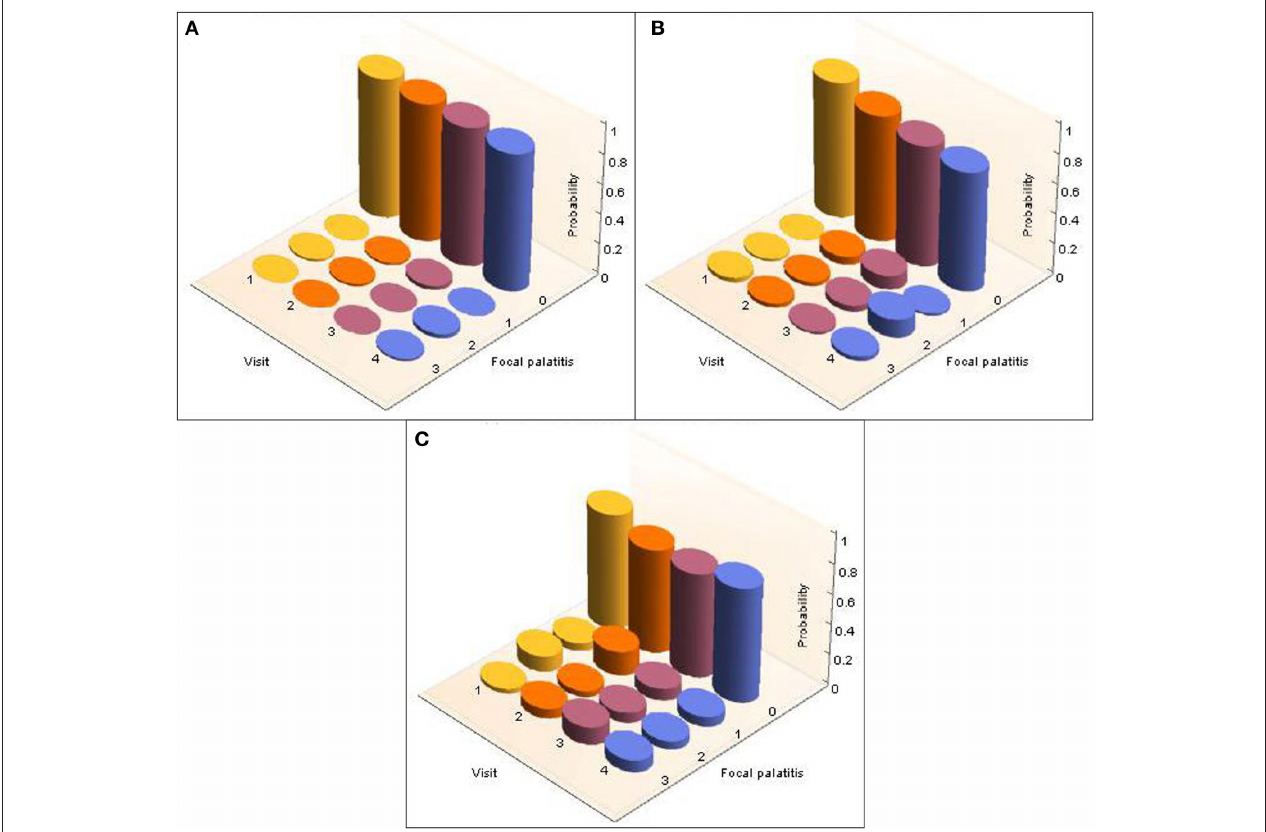
FIGURE 4 | 3-D column charts depicting the development of FP in terms of occurrence and severity in cheetahs from the Ann van Dyk Cheetah Centre (DW), seen on four different yet consecutive visits. The figures show the probabilities for FP in each of the palatal depressions that can potentially have FP. Note that dRPM2 and dLPM2, dRPM3 and dLPM3, and dRPM4 and dLPM4 were pooled. (A) Shows FP at the depressions palatal to the maxillary 2nd premolar teeth, (B) shows FP at the depressions palatal to the 3rd maxillary premolar teeth, (C) shows FP at the depressions palatal to the 4th maxillary premolar teeth.